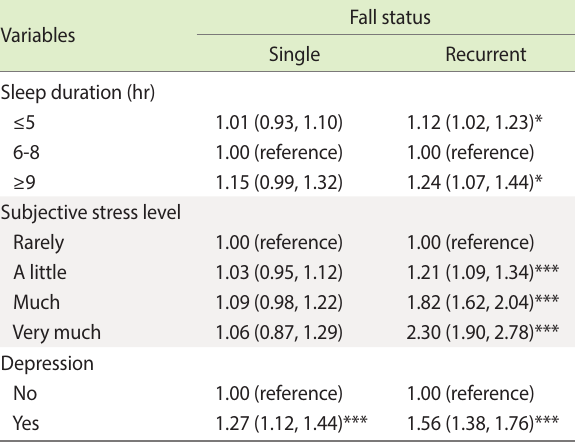
Table 5. Effects of mental health on risk of falls by fall status